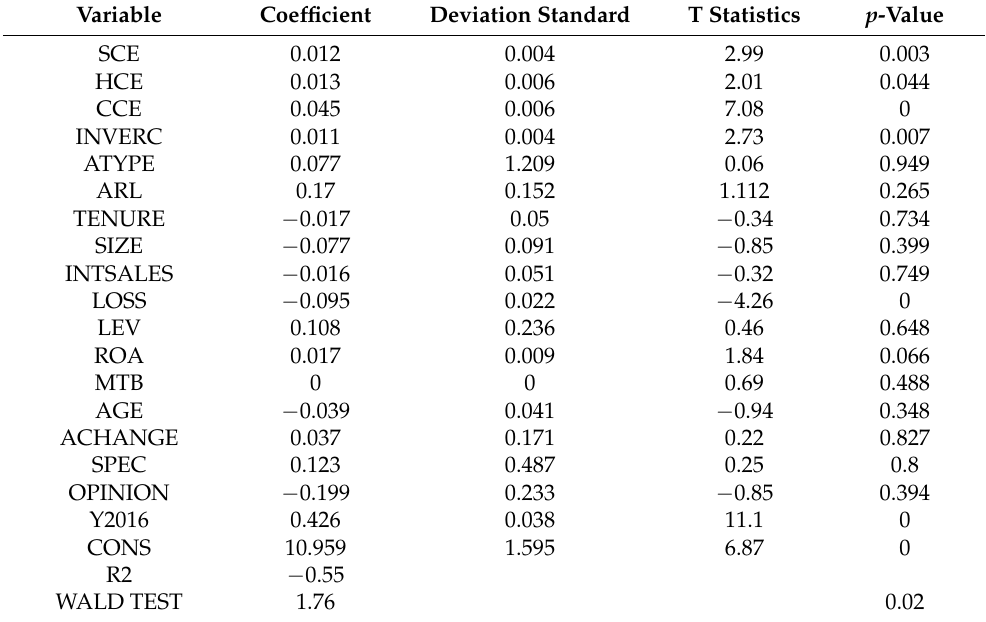
Table 11. The results of estimating the third model using the fixed-effects